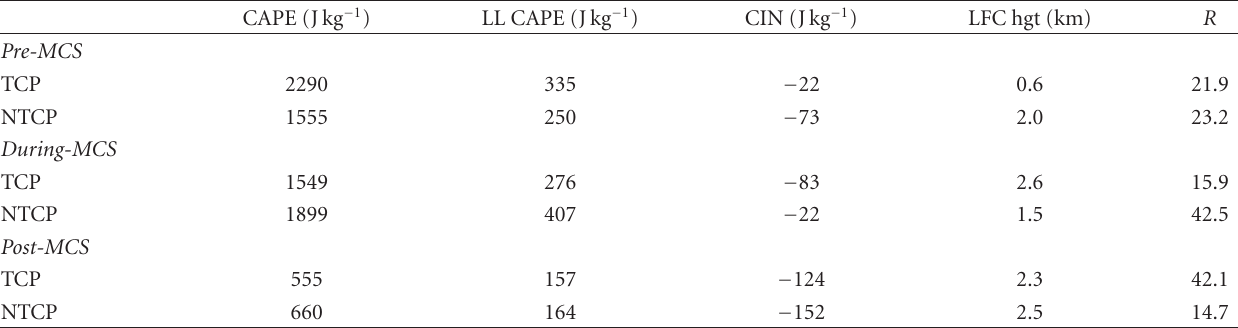
Table 2: Mean environmental indices prior to, during, and after MCS progression through the NPOL domain for each case type. LL indicates low-level and in this circumstance is a 0–5 km value. R is the Bulk Richardson number.